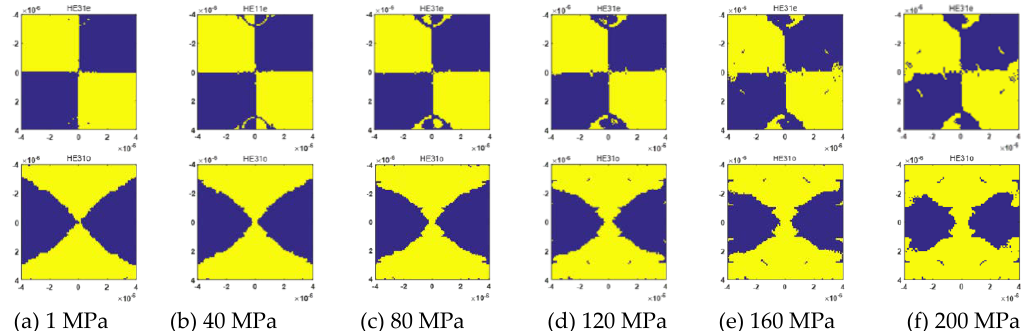
Figure 11 . Phase distribution of HE31 even and odd modes under the stress from 1 MPa to 200 MPa in the y direction.